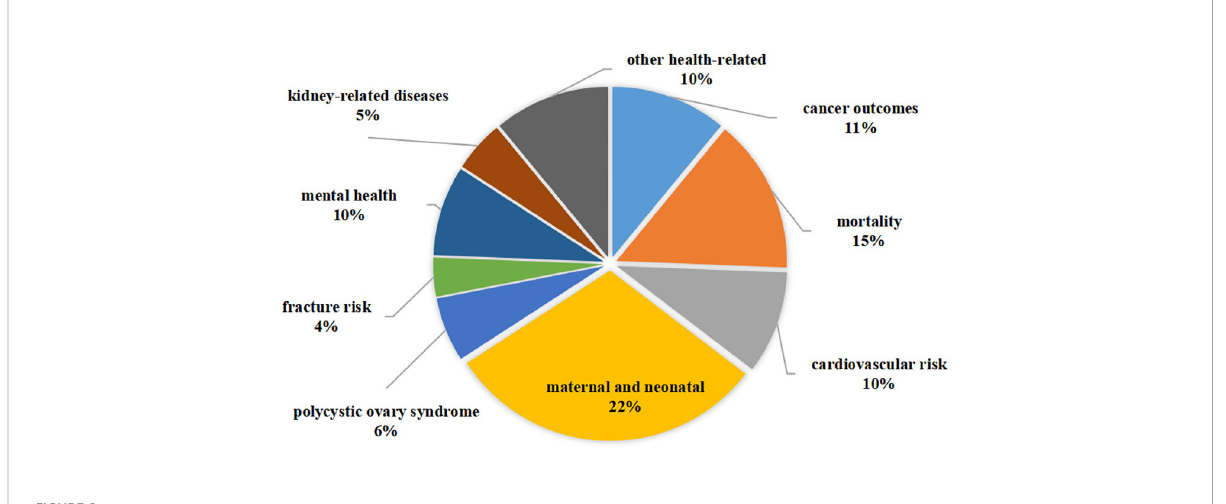
FIGURE 2 Map of outcomes associated with bariatric